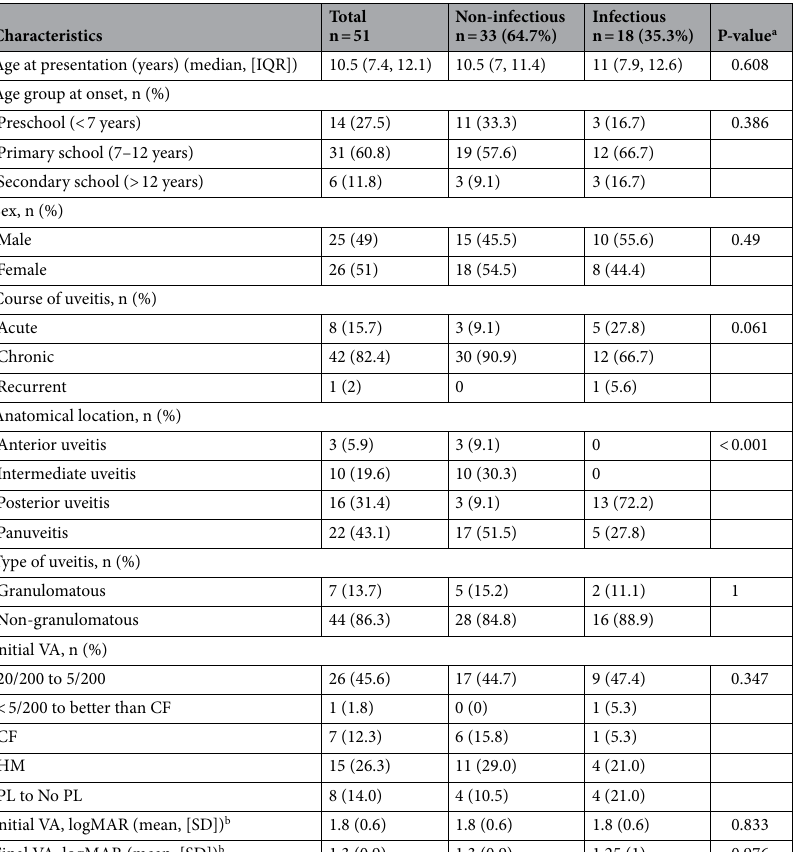
Table 1. Demographic and clinical characteristics of all 51 children (57 eyes) with uveitis presenting with severe visual impairment. CF counting fingers, HM hand motion, IQR interquartile range, logMAR logarithm of the minimum angle of resolution, PL perception of light, SD standard deviation, VA visual acuity. a P-value for the comparison between the non-infectious and infectious groups. b Analysis of a total of 57 uveitis affected eyes (38 eyes in the non-infectious group and 19 eyes in the infectious